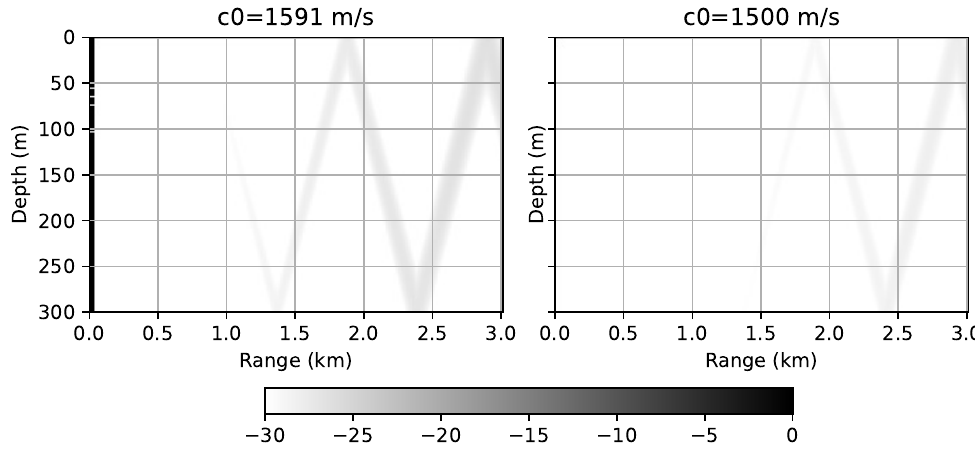
Figure 4. Waveguide with a perfectly reflective bottom. Error distribution between the Padé ap- proximation method and the WNI method (10log | ψ Pade − ψ WNI | ). ∆ x = 24 m, ∆ z = 0.07 m, c 0 = 1591 m/s ( left ) and ∆ x = 10 m, ∆ z = 0.06 m, c 0 = 1500 m/s ( right